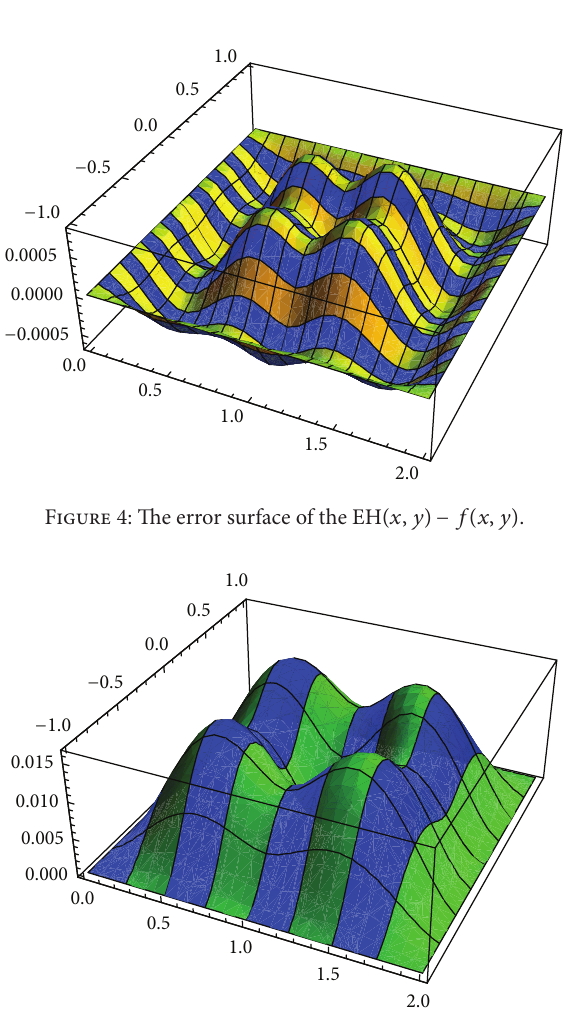
Figure 5: The error surface of the 𝐻(𝑥,𝑦) − 𝑓(𝑥,𝑦) .